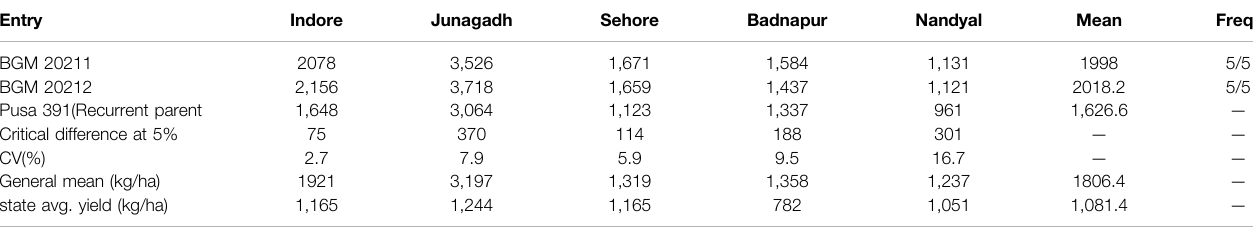
TABLE 4 | AVT-1 Comparison ofyield(kg ha − 1) performance ofBGM20211 and BGM20212 introgressionlinedeveloped inthe genetic background ofPusa391, withthe recurrent genotype at six locations in the Advanced Varietal Trials − 1 of ICAR – All India Coordinated Research Project on Chickpea conducted during 2018 – 2019